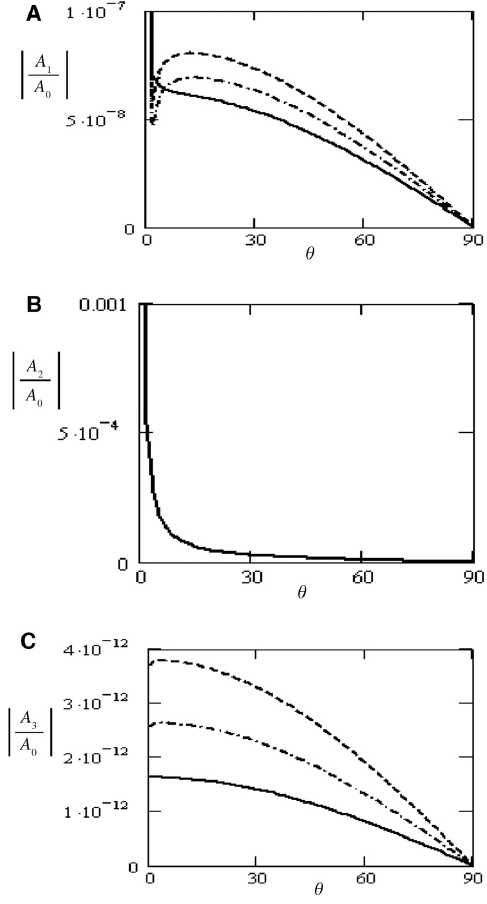
Figure 4: Variations of electric field ε = 0.01____, 0.02 – . – ., 0.04 – – – on the magnitude of amplitude ratios with respect to the angle of